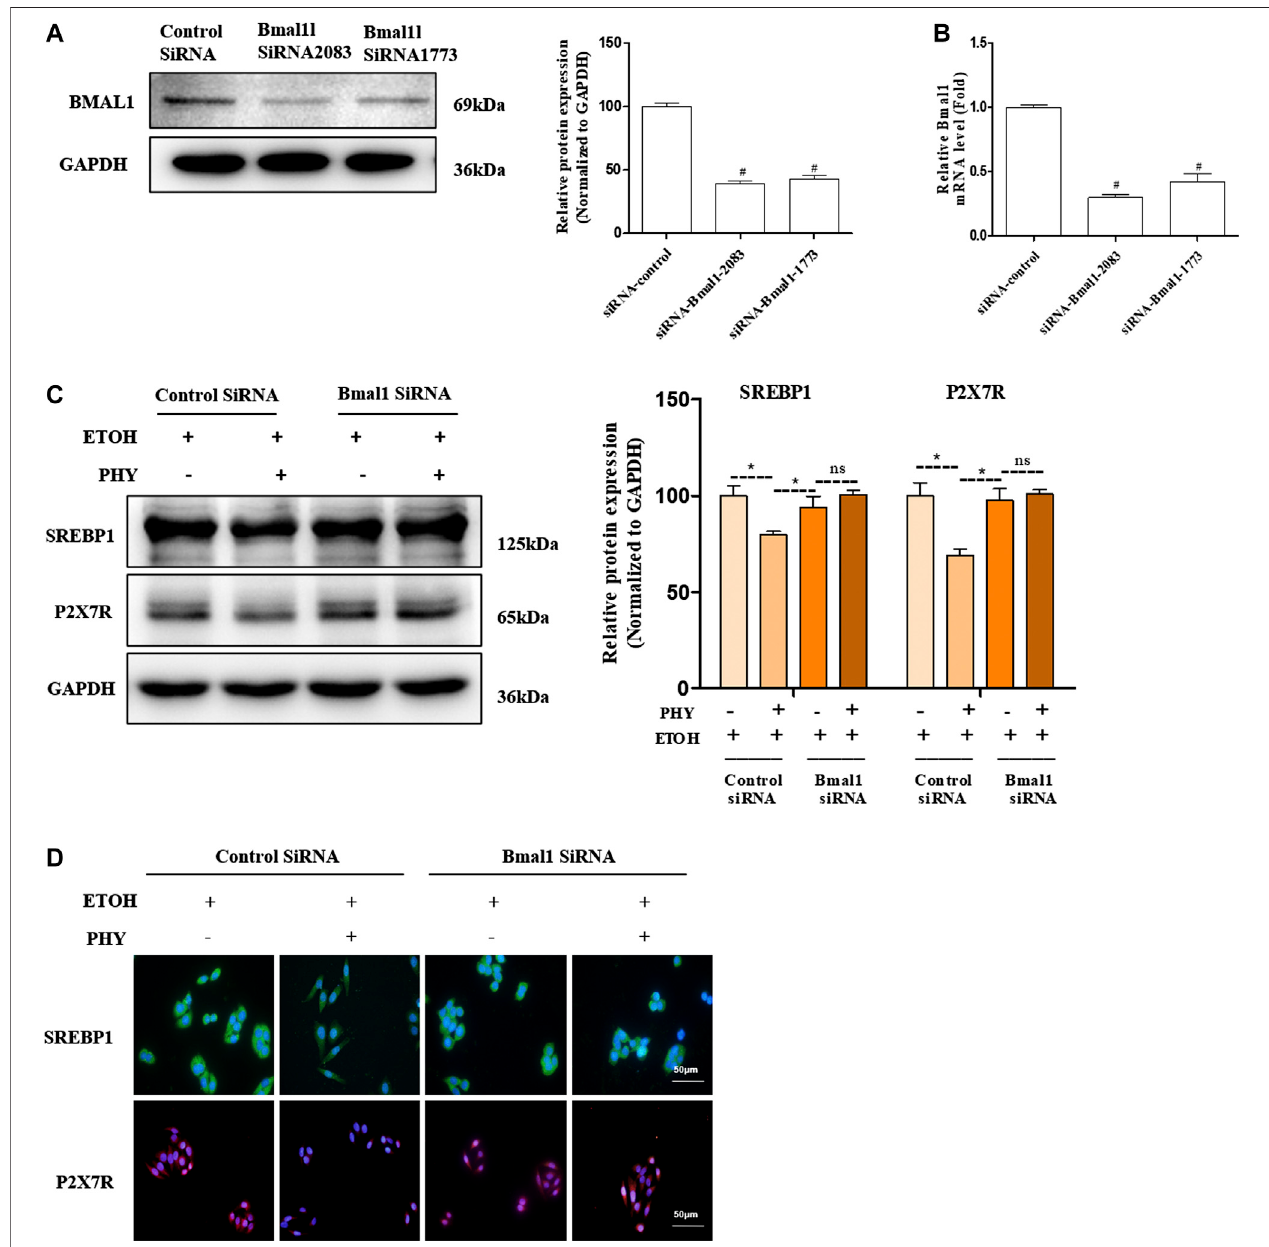
FIGURE 7 | Physcion attenuates intracellular lipid accumulation in a Bmal1-dependent way. (A) The protein expression of BMAL1. (B) The mRNA expression of Bmal1. (C) The protein expression of SREBP1, and P2X7R. (D) Immuno fl uorescence staining of SREBP1 and P2X7R. Values signi fi cantly different from the control are indicated by hash signs ( # p < 0.05). Values signi fi cantly different from the ethanol are indicated by asterisks (* p <